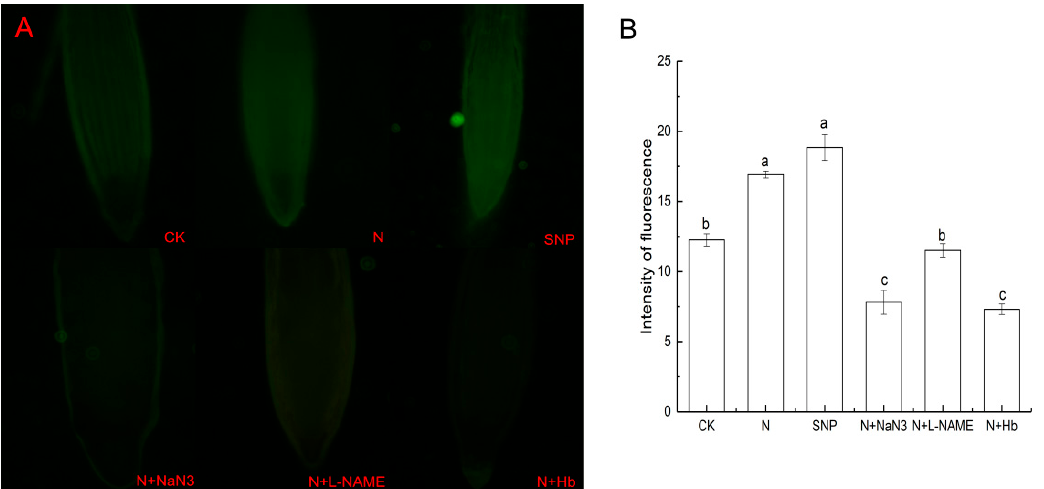
Figure 5. Effects of NO and NH 4+ :NO 3 − ratio on the NO level in root tissues under low light stress. ( A ) Representative fluorescence images of DAF-2 DA-loaded roots treated for 7 days. ( B ) Pixel intensity of fluorescence in tips of the root treated for 7 days. The data are mean ± SE (n = 3). Different letters indicate significant differences ( p < 0.05) between treatments. CK, NH 4+ :NO 3 − = 0:100; N, NH 4+ :NO 3 − = 10:90; SNP, 100 μ mol/L; N + NaN 3 , 50 μ mol/L NaN 3 was added in N solution; N + L-NAME, 25 μ mol/L. L-NAME was added in N solution; N + Hb, 0.1% Hb was added in N solution.